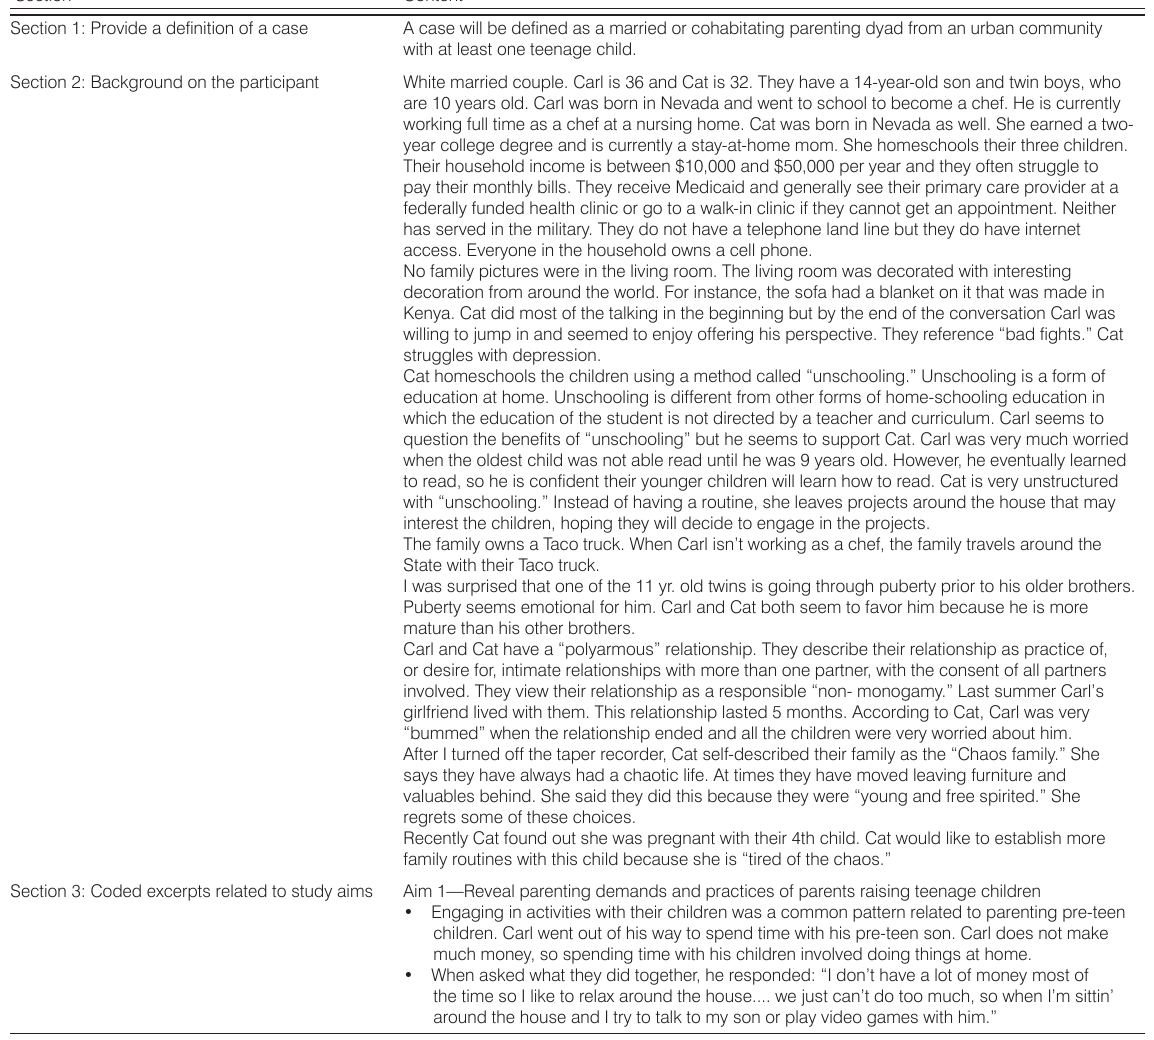
Table 1. Example of an interpretive